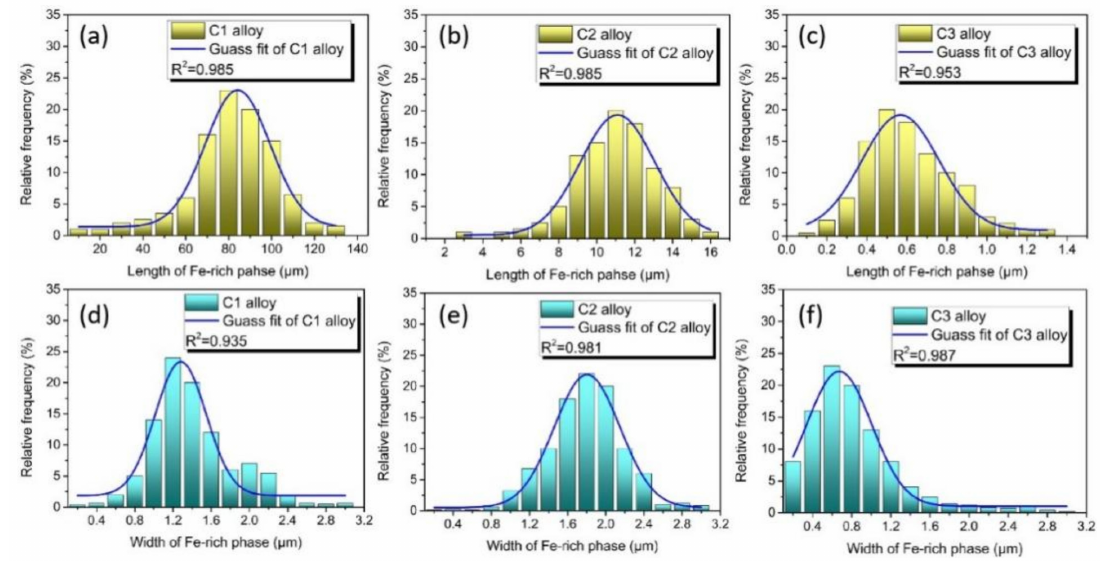
Figure 5. Statistical distribution of the length of Fe-rich phase of the ( a ) C1, ( b ) C2, and ( c ) C3 alloys, ( d,e,f ) are the statistical distribution of the width of Fe-rich phase of the C1, C2 and C3 alloys,